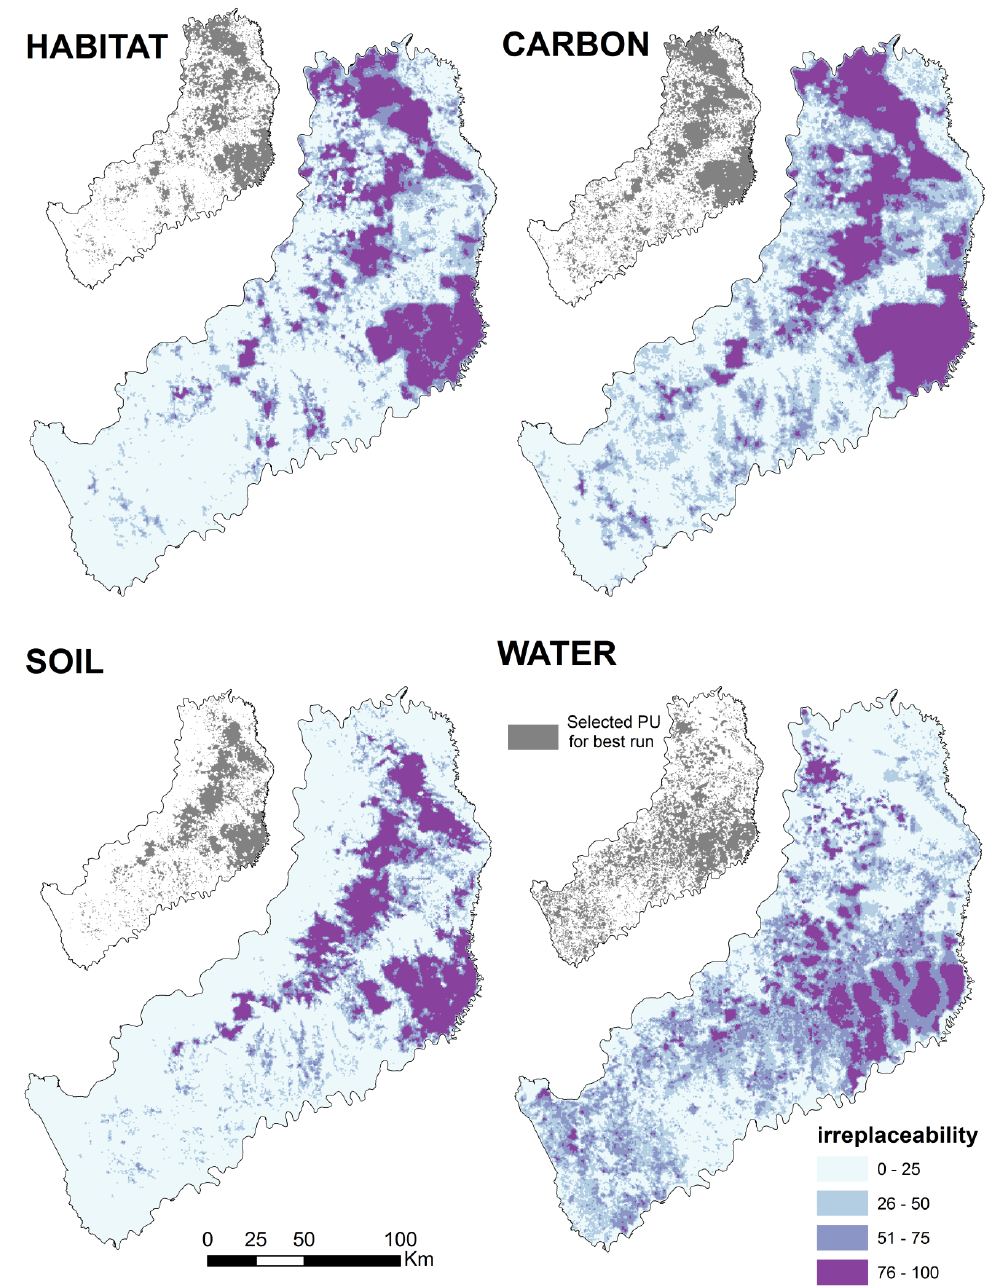
Figure 4. The Marxan summary solutions (irreplaceability, color tones) and the best solution (gray) of planning units (50-ha hexagons) for habitat and ecosystem services ( i.e. , conservation